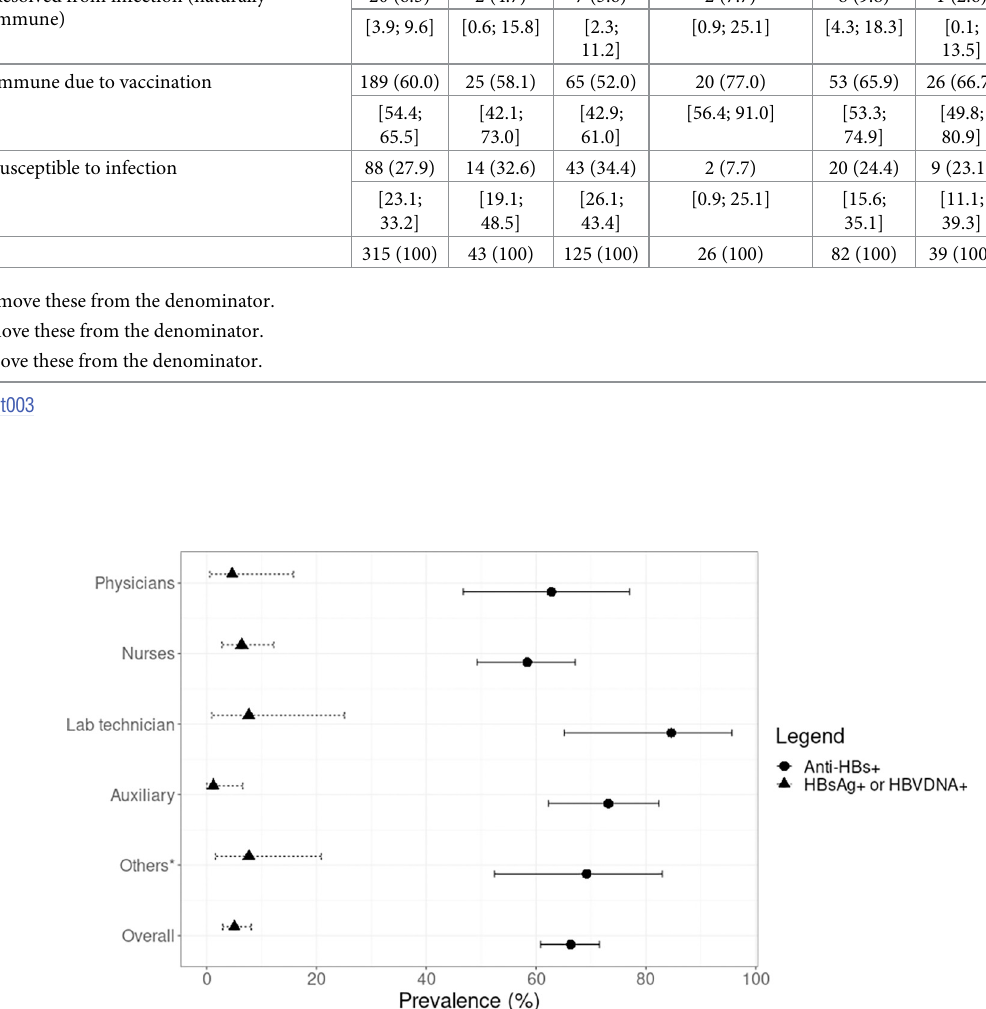
Fig 1. Prevalence of hepatitis B infection and immunity against HBV among healthcare workers. � Other providers with non-university degrees, including dental and oral care, eye care, preventive medicine, instrumentalists, anaesthesiology technicians, ophthalmology technicians, and imageology